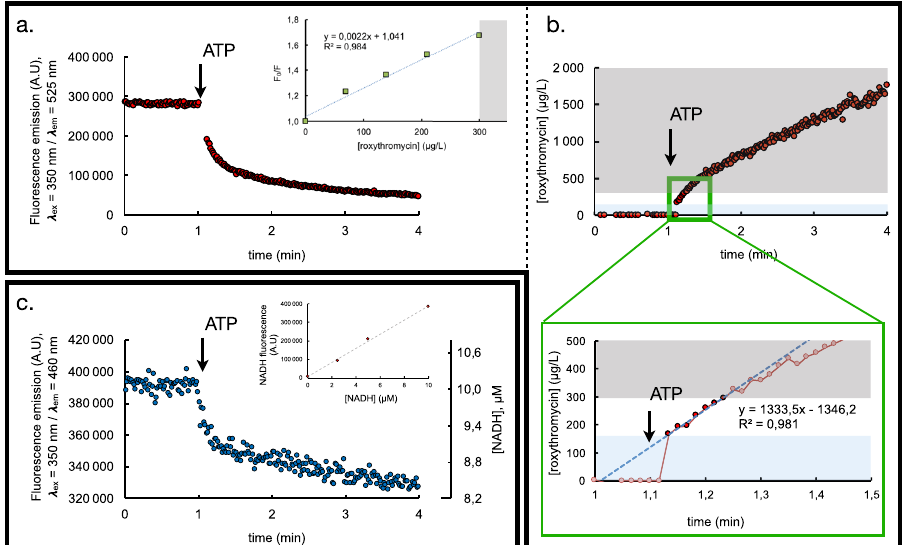
Fig. 2 Real-time monitoring of roxithromycin transport and ATP hydrolysis within a reconstituted MacAB-TolC pump. a CdTe quantum dot fl uorescence is measured as a function of time after tenfold dilution of the MacAB / TolC complex into 20 mM Tris pH 8, 50 mM NaCl, 2 mM MgCl addition of 7 µ M roxithromycin (not shown here for the sake of clarity) and of 1 mM ATP (represented by the arrow). The MacAB nanodiscs (25 µ g MacB, as standardized by SDS PAGE densitometry, see Supplemental Fig. S2) and TolC proteoliposomes were preincubated for at least 1 h at room temperature prior to their addition in the fl uorescence cuvette, roxithromycin was added in the cuvette at least 10 min before addition of ATP. Changes due to dilution have been corrected for. inset: Quenching of the quantum dots fl uorescence in the presence of increasing concentrations of roxithromycin shows that the fl uorescence variation is proportional to the quantity of quencher up to a roxithromycin concentration of 300 µ g/L. b Thanks to the above-described proportionality relationship, CdTe fl uorescence quenching is converted into a quantity of roxithromycin transported as a function of time into the lumen of the liposome. The gray area represents the substrate concentration range for which proportionality does not hold. Values therein must not be taken into account. The green panel is a zoom of the region of interest. The blue area highlights the fi rst fast phase of transport. c NADH fl uorescence is measured as a function of time after tenfold dilution of the MacAB nanodiscs (c.a 10 µ g MacB, as standardized by SDS PAGE densitometry, see Supplemental Fig. S1) into 20 mM Tris pH 8, 50 mM NaCl, 2 mM MgCl 2 containing the coupled-enzyme assay (see Methods for details) and addition of 1 mM ATP (represented by the arrow). Changes due to dilution have been corrected for. inset: linearity of NADH fl uorescence over the range of concentration used in the assay. NADH fl uorescence was measured with an excitation wavelength set at 350 nm and emission at 460 nm. Measurements were performed at room temperature (20 °C) in 20 mM Tris pH 8, 50 mM NaCl, 2 mM MgCl 2 . The proportionality coef fi cient allowed the conversion of the fl uorescence changes (primary y axis, left) into [NADH] variations (secondary y axis,